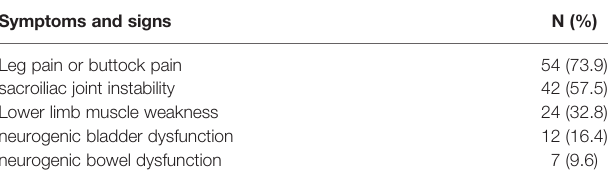
TABLE 2 | Symptoms and signs of the 73 patients. Symptoms and signs